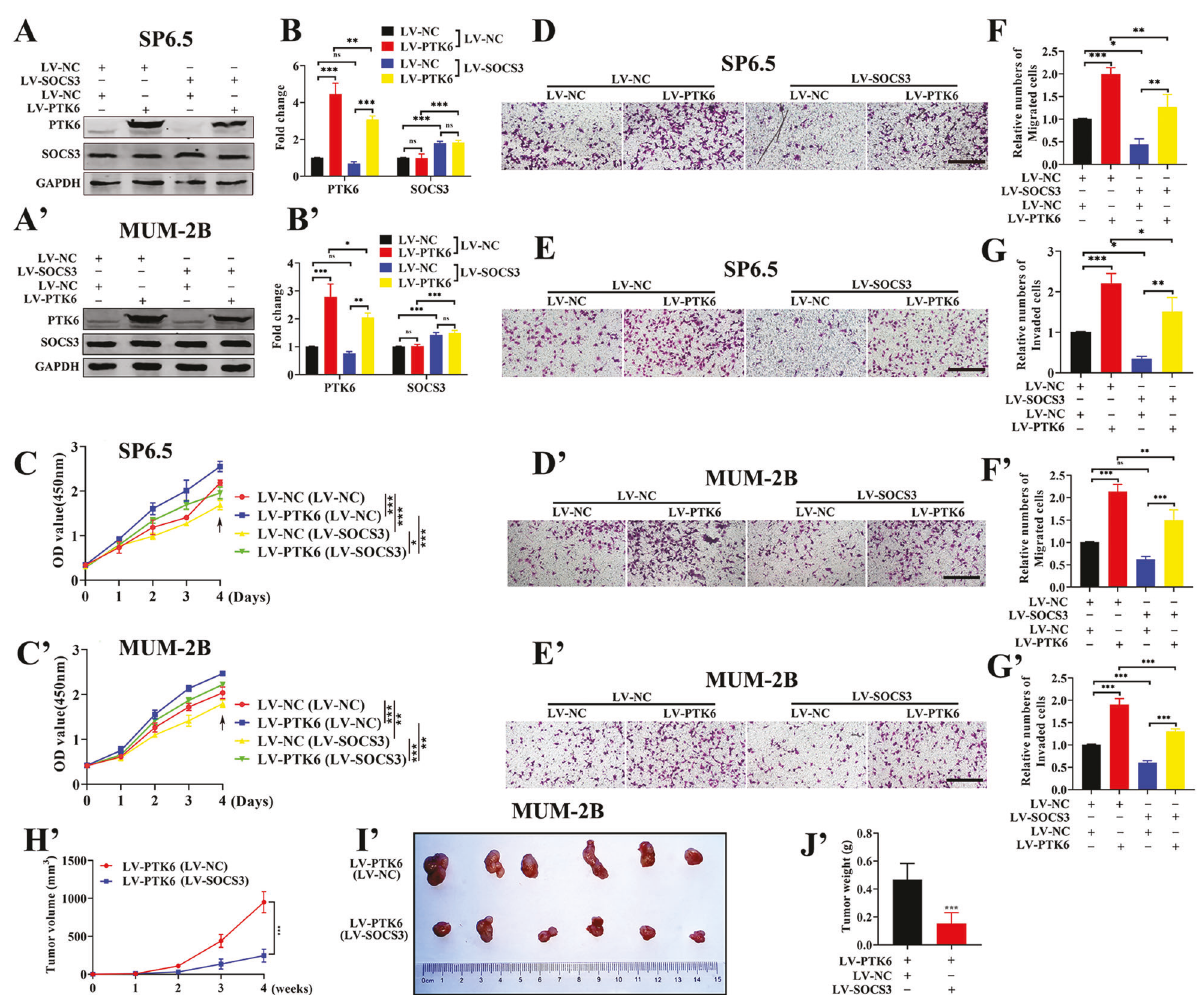
Fig. 7 Overexpressing SOCS3 can partially attenuate the PTK6-induced promotion of UM cell proliferation, migration, and invasion in vitro and in vivo. A , B and A ’ , B ’ Western blotting analysis of SOCS3 and PTK6 in the LV-NC group or LV-PTK6 group supplemented with LV- NC and LV-SOCS3. C – G and C ’ – G ’ Proliferation, migration, and invasion analysis of the LV-NC group or LV-PTK6 group treated with LV-NC and LV-SOCS3. The above data were analyzed using two-way ANOVA with Bonferroni. H ’ The volume of tumors formed in the LV-PTK6/LV-NC group and LV-PTK6/LV-SOCS3 group. The data were analyzed using two-way ANOVA with Bonferroni. I ’ Photographs of tumors from the LV- PTK6/LV-NC group and LV-PTK6/LV-SOCS3 group. J ’ The weight of tumors formed in the LV-PTK6/LV-NC group and LV-PTK6/LV-SOCS3 group. The data were analyzed using Student ’ s t -test. ( A – G : SP6.5 cell; A ’ – J ’ : MUM-2B cell; scale bar: 100 µm; data were presented as the mean ± SD; n = 3 – 6; ns no signi fi cant difference, * p < 0.05, ** p < 0.01, *** p < 0.001). nude mice, and we examined the expression of PTK6 and SOCS3 group were increased compared with those in the LV-NC group proteins in the two groups of tumors (S14C, F). As shown in Fig. regardless of whether LV-NC or LV-SOCS3 plasmids were applied, 7H ’– J ’ and S11H – J, the volume and weight of tumors in the LV- and the proliferation, migration, and invasion abilities of the LV- PTK6/LV-SOCS3 group were smaller than those in the LV-PTK6/ PTK6 group and the LV-NC group applied LV-SOCS3 plasmids LV-NC group. The above data demonstrated that SOCS3 can were decreased compared with those of the LV-PTK6 group and attenuate UM tumorigenesis induced by PTK6 in vivo and the LV-NC group applied LV-NC plasmids. Finally, LV-PTK6/LV-NC in vitro. and LV-PTK6/LV-SOCS3 cells were injected subcutaneously into Cell Death and Disease (2023)